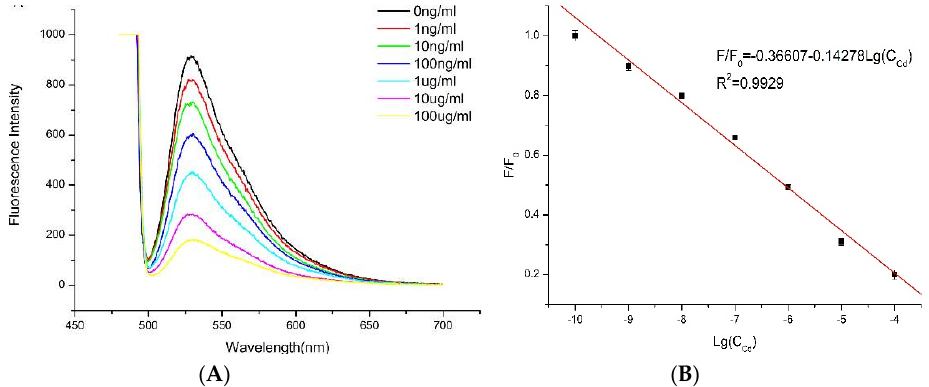
Figure 2. ( A ) Fluorescence spectra of solutions with different concentrations of Cd 2+ ; ( B ) The linearity of F / F 0 with respect to the logarithmic Cd 2+ concentrations. Table 1. Comparison of different Cd 2+ detection methods.